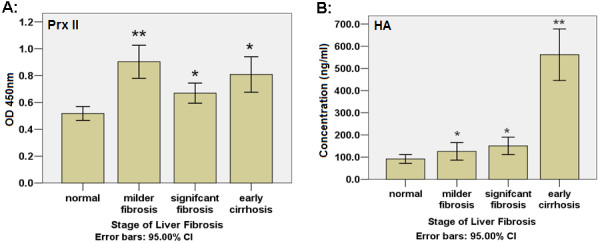
Human plasma levels of Prx II and HA. A: the plasma levels of Prx II were significantly elevated in patients with milder grade fibrosis compared to those in normal controls. The plasma level of Prx II in the late stage fibrosis and early cirrhosis were reduced compared to that in the early stage, but still higher than the normal controls. B: a significantly elevated HA plasma level among the early cirrhosis patients compared to normal controls and fibrosis patients.Compared to normal:* P < 0.05, ** P < 0.01